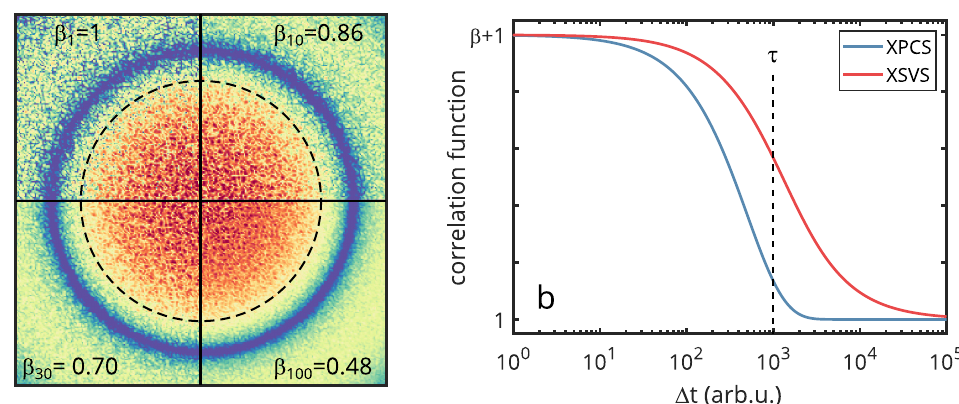
Figure 5. ( a ) Speckle patterns calculated from diffusing disks with different exposure times ranging from from 1 to 100. The contrast calculated for the q -value marked by the dashed black circle drops from 1 to 0.48. ( b ) g 2 ( ∆ t ) compared to the XSVS function using the same intermediate scattering